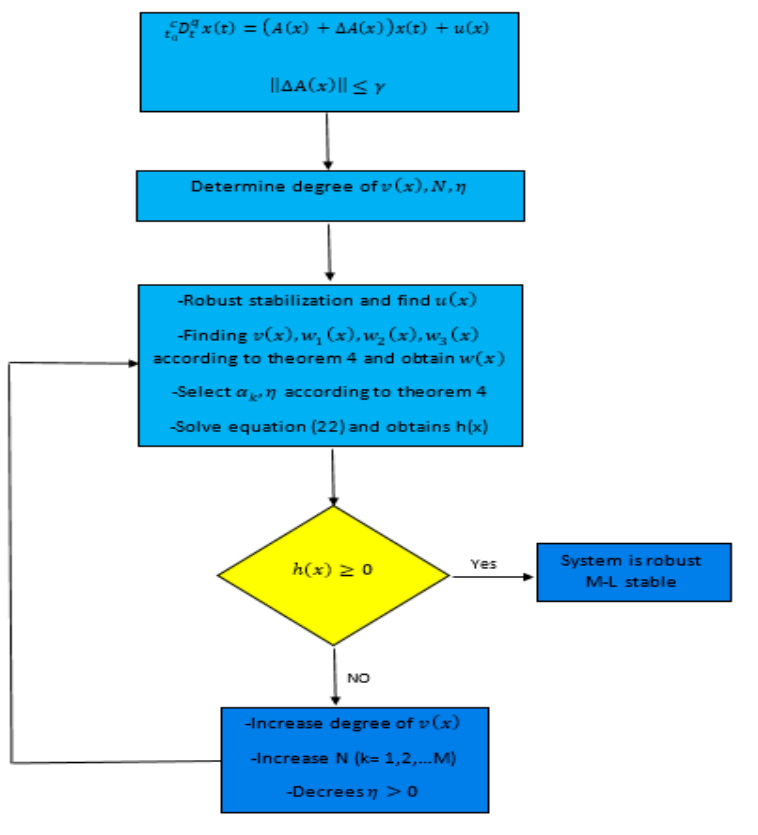
Figure 1. The proposed